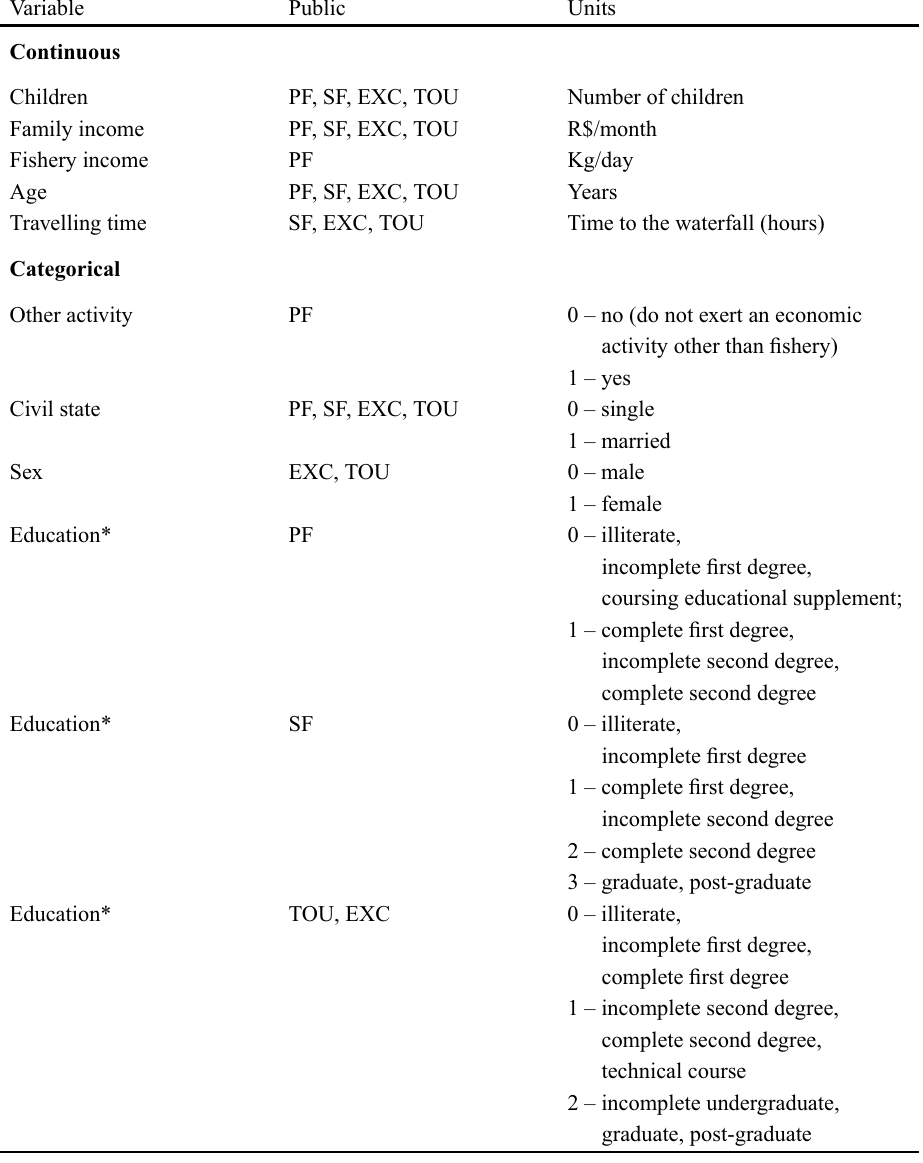
Variables tested in the logistic regressions and in ANCOVAs for the different publics of the Emas waterfall. Professional fishers (PF), sport fishers (SF), excursionists (EXC) and tourists